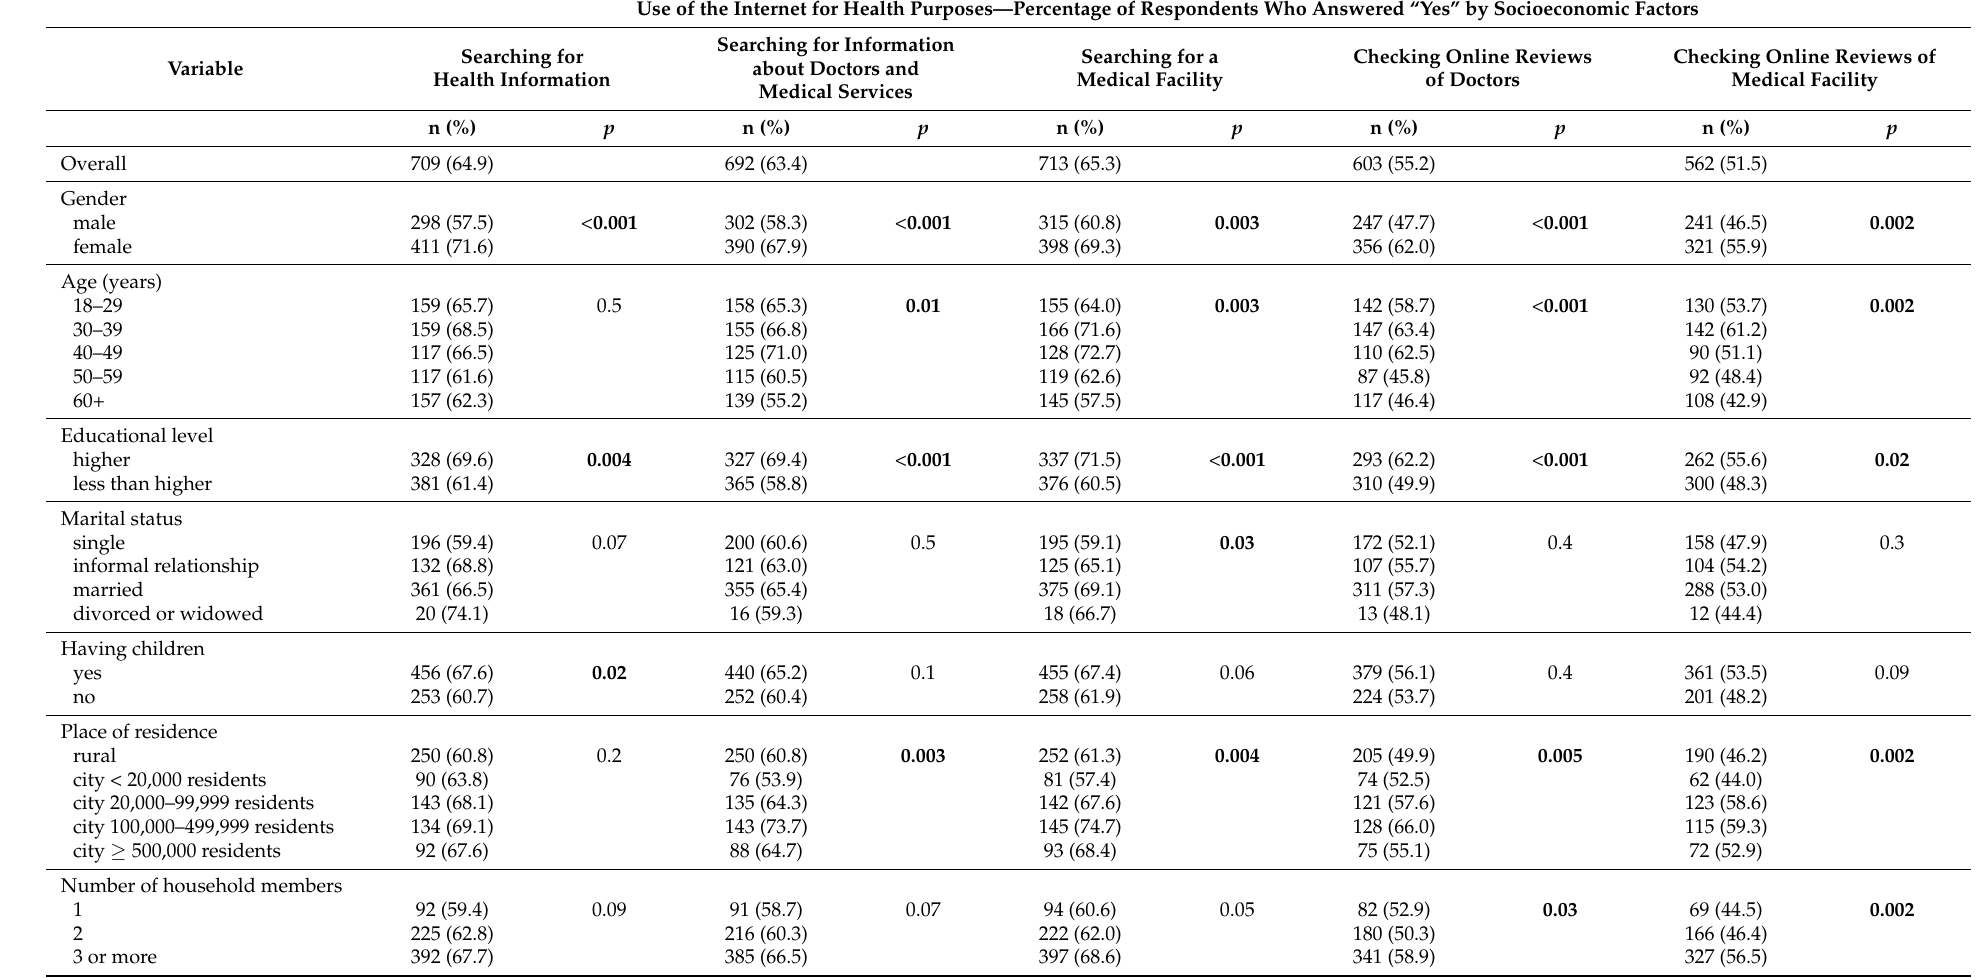
Table 2. The use of the Internet for health purposes among adults in Poland (n =